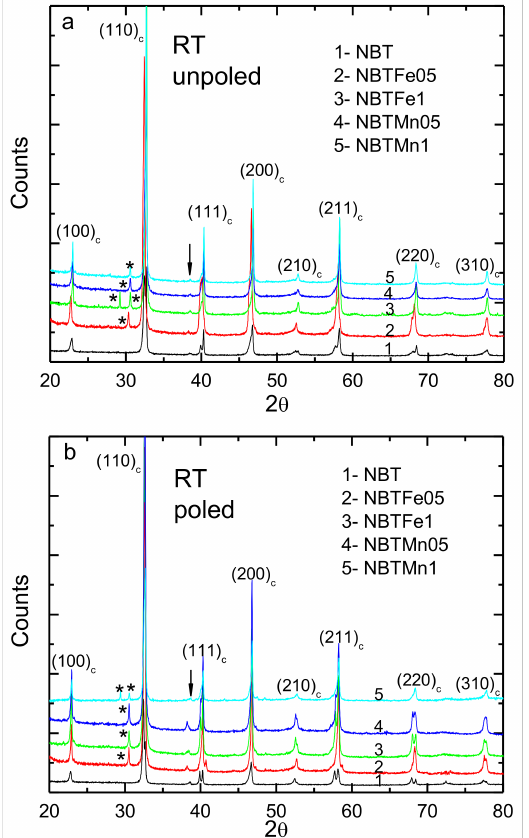
Figure 2. The room-temperature X-ray pattern of the investigated samples in ( a ) unpoled and ( b ) poled states. The “c” subscript corresponds to the cubic phase. The “*” shows secondary phase. The arrow shows the superlattice reflection of the rhombohedral R3c